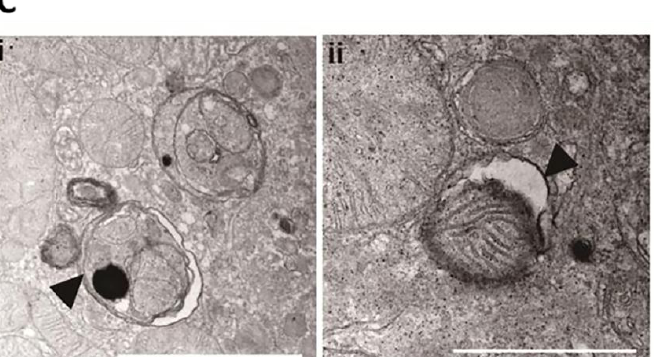
Figure 2. Mitochondrial fragmentation and mitophagy induction in proximal tubule cells during renal ischemia–reperfusion injury. ( A ) Mitochondrial fragmentation was observed in proximal tubule cells immediately after renal ischemia–reperfusion (IR). The fragmentation was remarkably increased in IR kidney. Asterisks indicate elongated (>2 μm) mitochondria [29]. ( B ) Quantification of mitochondrial fragmentation [29]. ( C ) Representative TEM images of autophagosomes (pointed to by the arrowhead in the left panel) and a mitophagosome (pointed to by the arrowhead in the right panel) in renal proximal tubule cells after IR[45].